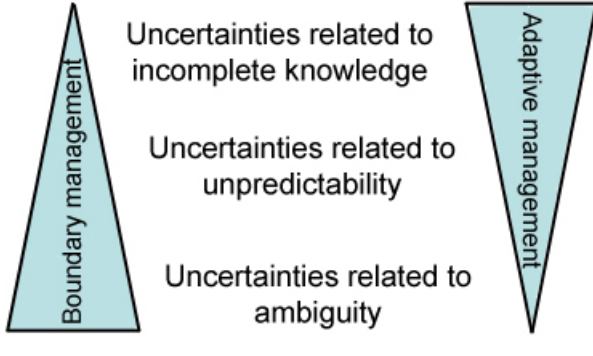
Fig. 5. Schematic representation types of